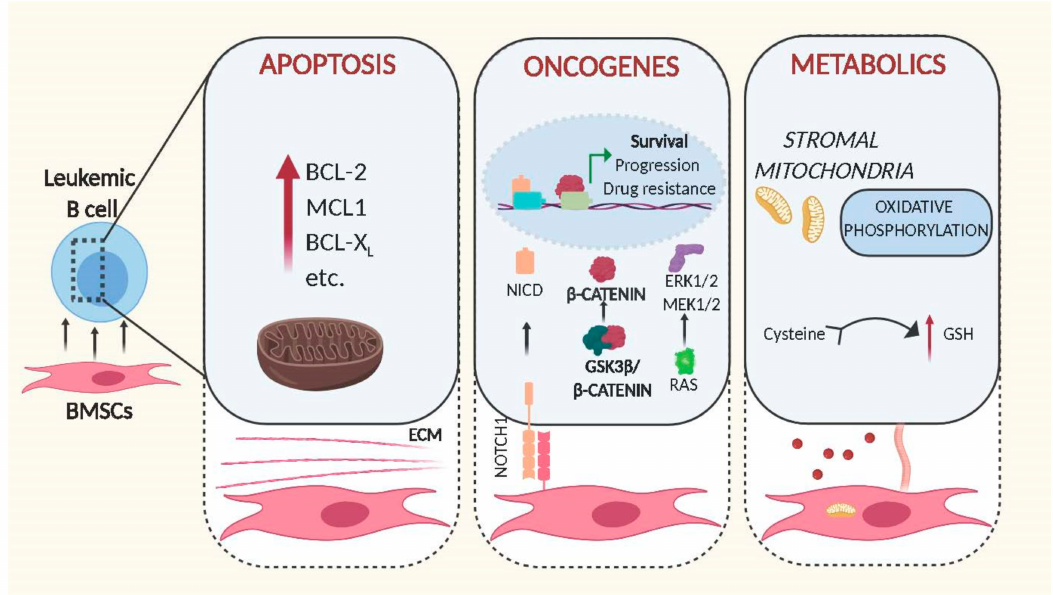
Figure 1. Schematic representation of intracellular changes mediated by bone marrow stromal cells in leukemic B cells. Cell–cell contact and release of soluble factors mediated by BMSCs increase the leukemogenicity of transformed B cells through expression of anti-apoptotic proteins (left panel), activation of oncogenic signalling (middle) and alteration of metabolic pathways (right). Figures were generated using